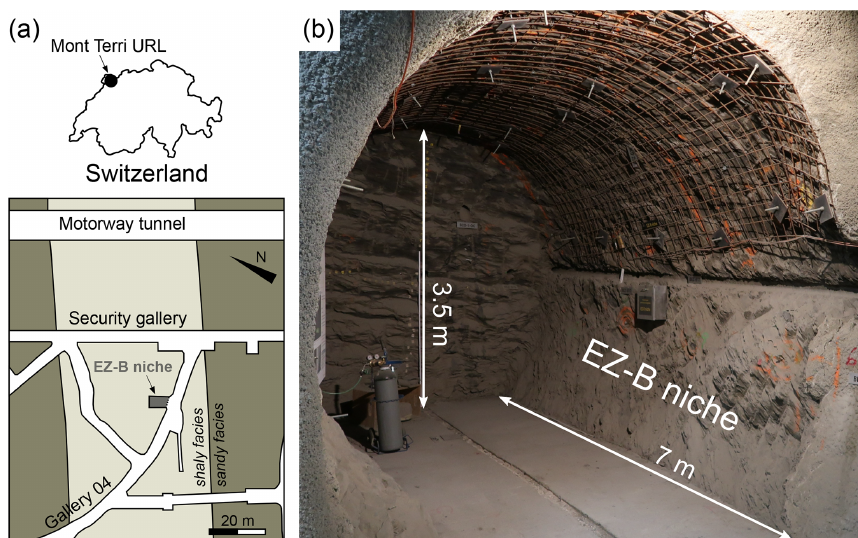
Figure 1. (a) Location of the Mont Terri underground rock laboratory (URL) alongside the security gallery of the Mont Terri motorway tunnel and the EZ-B niche situated in the shaly facies of the Opalinus Clay. (b) Photo and dimensions of the EZ-B niche where data acquisition was conducted. In the entrance area, shotcrete partly covers the rock surface on the left and right side